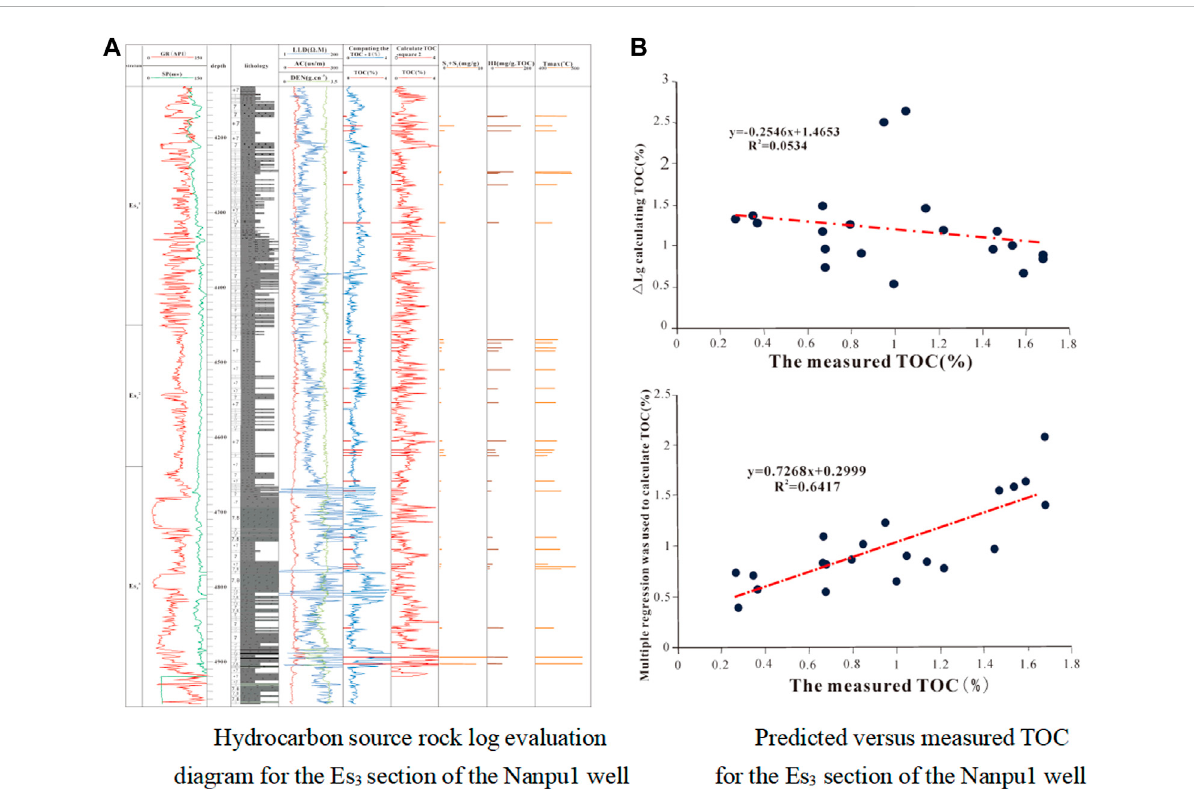
FIGURE 9 The diagram of logging evaluation and relationship between prediction and measured of Es 3 source rock in well Nanpu1. (A) Hydrocarbon